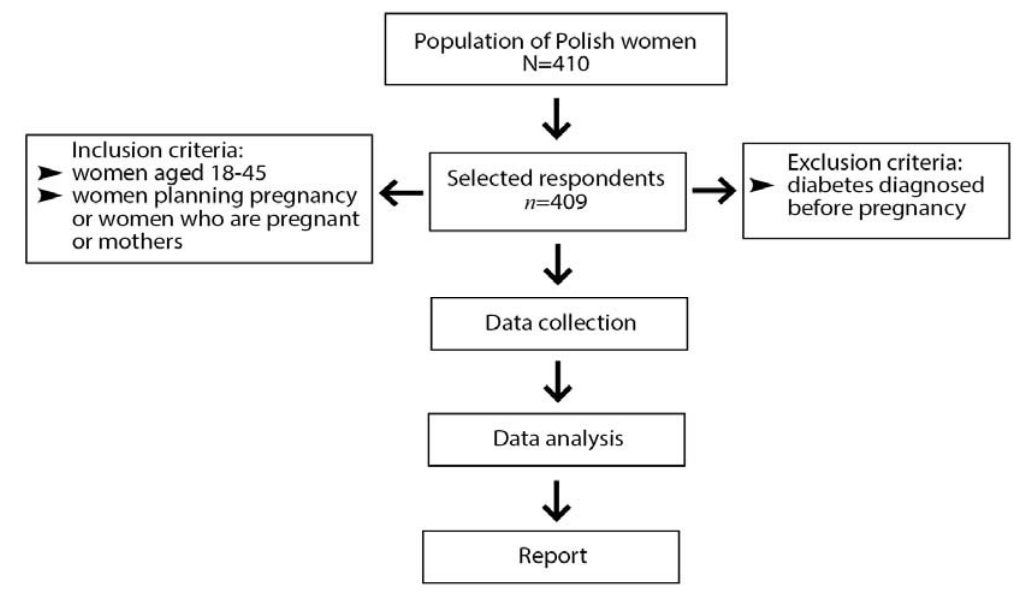
Figure 1. Scheme of women included in the study.